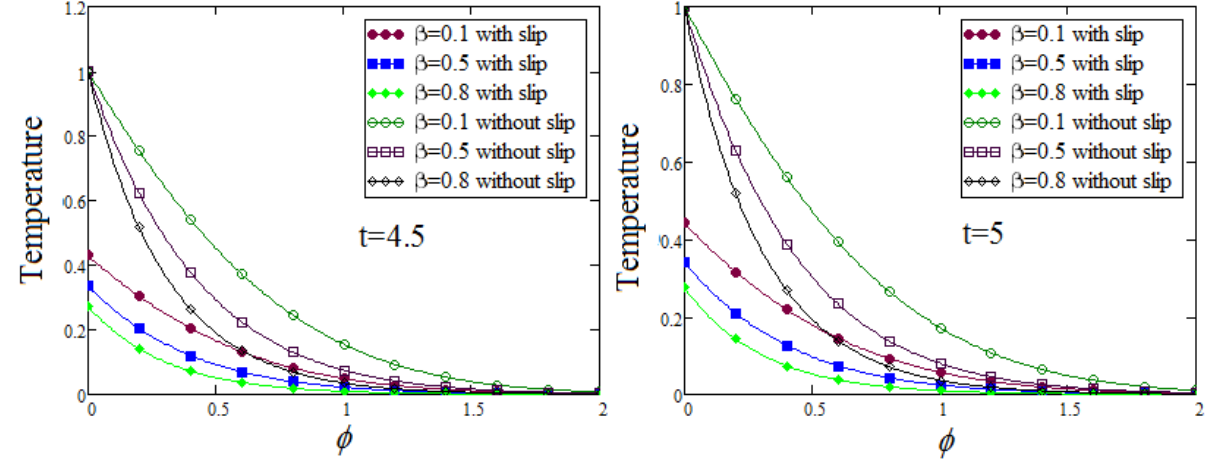
Figure 3. Graphical representations of temperature profile in the presence of slip and no slip condi- tions by taking the distinct values of β at two different levels of time, when Pr = 12, ω = 0.5, ℘ = 0.4, α = 0.3, and γ = 0.5.